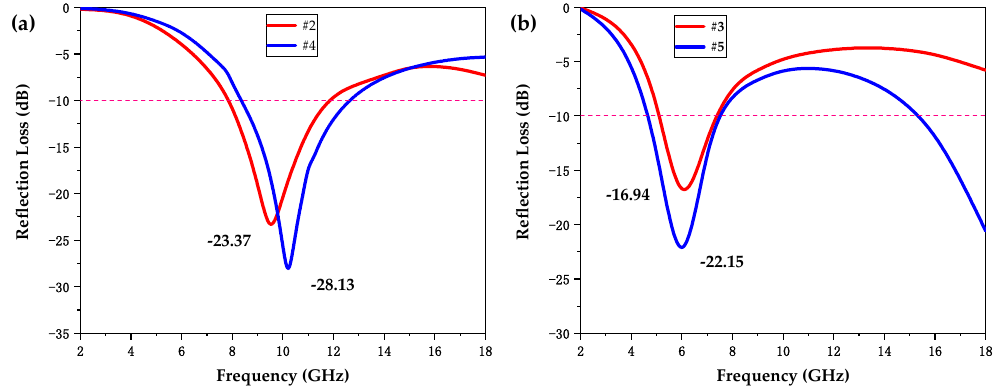
Figure 8. ( a ) Comparison of the experimental RL spectrums of samples #2 and #4 at the same thickness of 2.5 mm. ( b ) Comparison of the experimental RL spectrums of samples #3 and #5 at the same thickness of 3.5